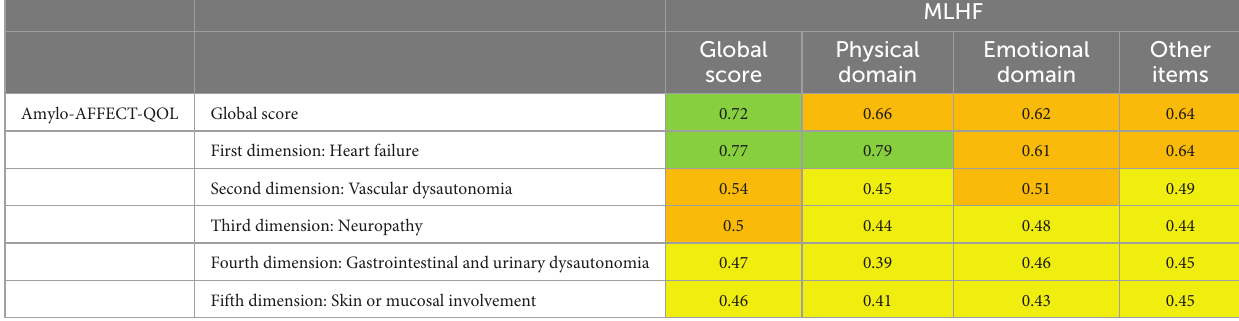
TABLE 5 Comparison between scores of Amylo-AFFECT-QOL and MLHF questionnaires—Convergent validity